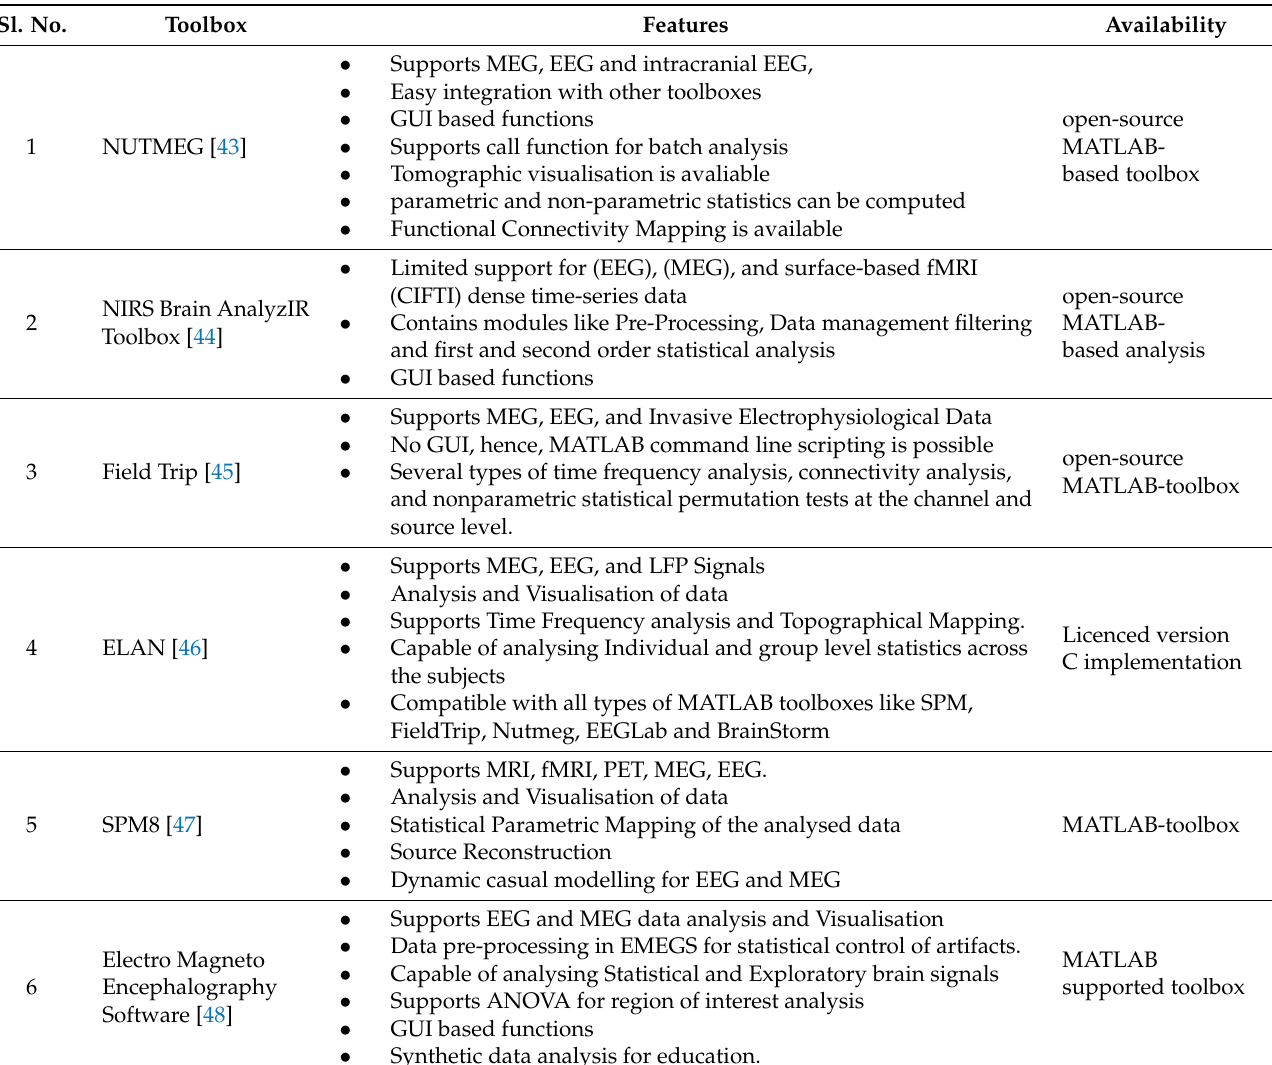
Table 1. Open source and licensed toolbox and their features for the analysis of MEG/EEG databases. Sl.